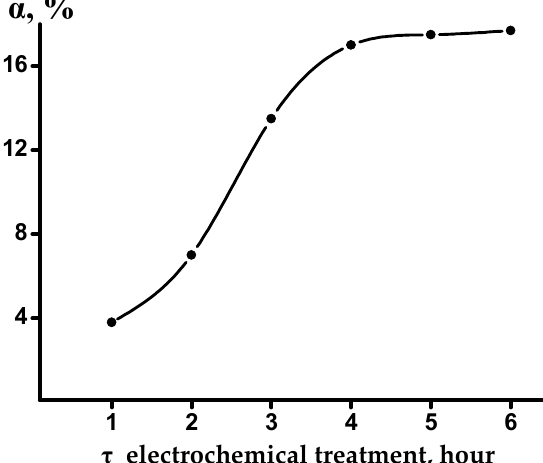
Figure 8. Potassium extraction ( α , % K 2 O) from phlogopite by electrochemical treatment. For further experiments, a fraction of flakes of 40–60 µ m, with a thickness of up to 1 µ m, was used, which was obtained by grinding and a subsequent classification of the material [21]. Below are the SEM images of the mica particles. Figure 9 shows the SEM images of phlogopite particles, according to the processing scheme shown in Figure 4, as follows: 1—initial particles, a thick multi-layer flake with an irregular surface and sharp edges; 2—phlogopite particles after electrochemical splitting, thin flakes, with a smooth, even surface and smoothed edges; 3—particles after grinding, represented by different fractions (large and small); 4—particles after sieving, represented by the fraction of particles of 40–60 µ m, suitable for further coating with titanium dioxide.